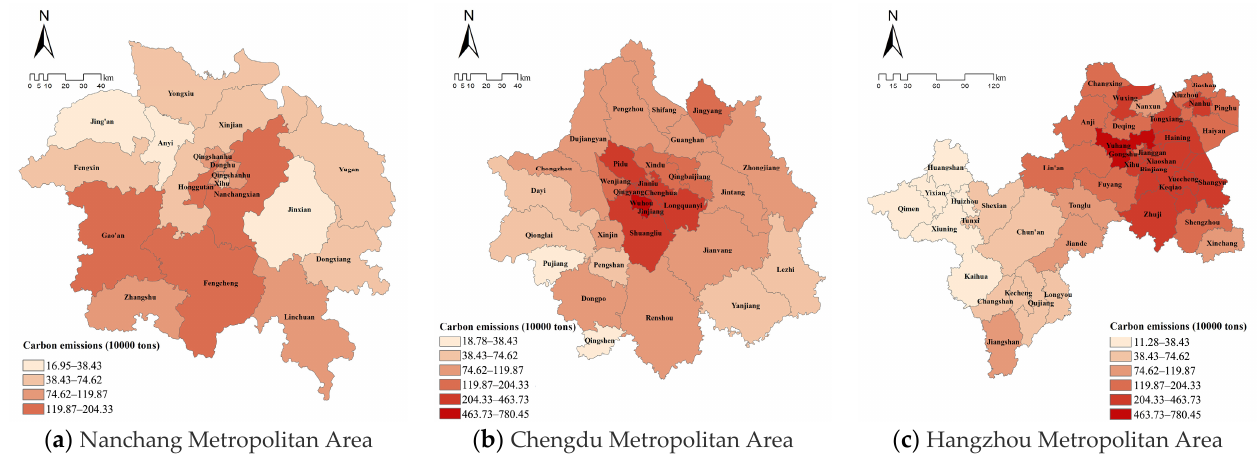
Figure 3. County-level distribution of LUCE in Nanchang, Chengdu, and Hangzhou metropolitan areas.